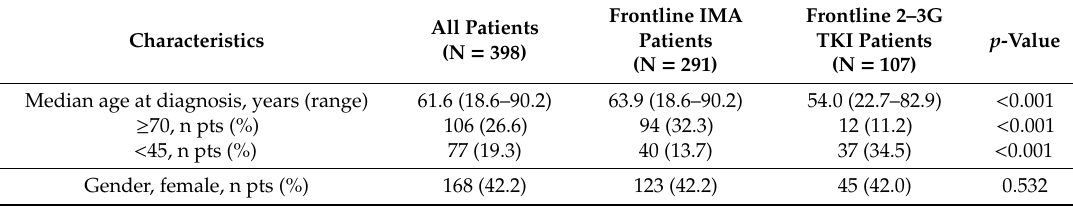
Table 1. Baseline characteristics of the study population (N = 398